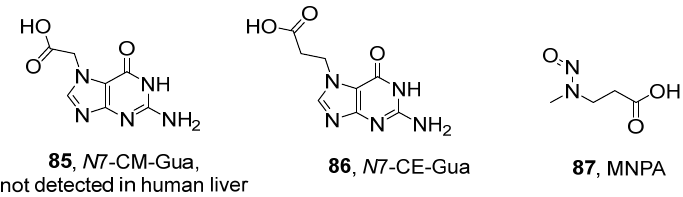
Figure 8. Chemical structures of N7 -CM-Gua, N7 -CE-Gua, and MNPA.